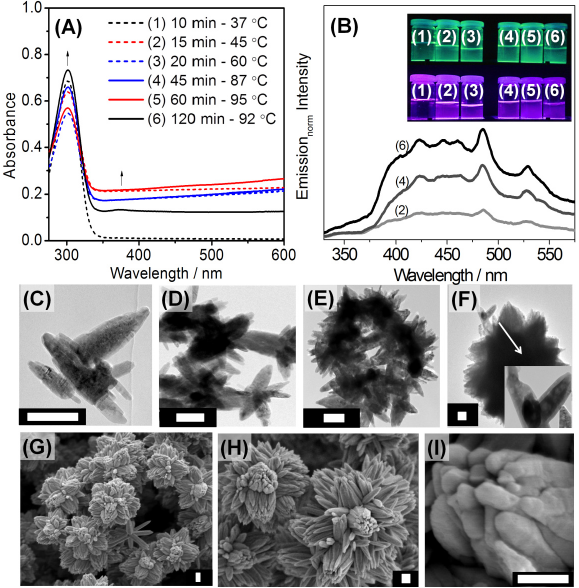
Figure 2: (A) UV-vis absorption spectra and (B) emission spectra (λ = 320 nm) at different states of growth for ZnO NFs. Inset of figure B shows the photoluminescence photographs of each synthesis state excited at short (top, λ = 254 nm) and long (λ = 365 nm) UV wavelength. Micromorphology of (C–E) the early growth, (F-H) the as-synthesized, and (I) the annealed ZnO NFs. All white bars equal to 200